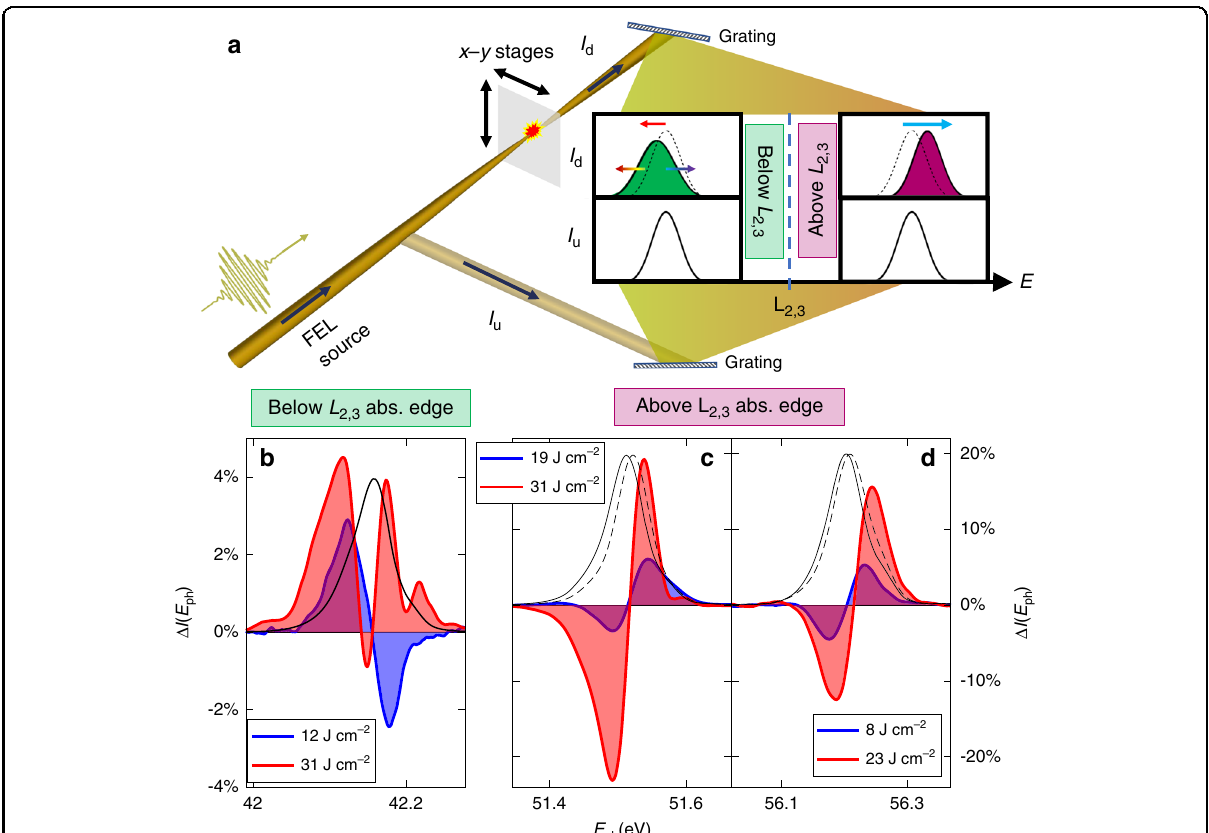
Fig. 1 Experimental results in Mg. a Simpli fi ed sketch of the experimental setup (see Methods section). The single-shot spectra of the pulses are collected with two spectrometers (depicted as a couple of gratings) upstream ( I u ( E ph )) and downstream ( I d ( E ph )) of a Mg sample foil. The NLEs are obtained comparing the two FEL spectra, demonstrating a spectral blue-shift above the L 2,3 absorption edge. On the contrary, spectral red-shift and broadening can be observed below edge. The averages of the differences Δ I = 〈 I d − I u 〉 is reported for a FEL photon energy (~42.1 eV) below the Mg L 2,3 -edge ( b ) and for two photon energies (~51.5 and ~56.2eV) above it ( c , d ). The red and blue curves correspond to Δ I at the highest and lowest fl uence. Averaged FEL spectra 〈 I 〉 , scaled to improve readability, are shown by solid black lines. The blue-shift in c,d can also be appreciated u ( E ph ) comparing 〈 I u ( E ph ) 〉 and 〈 I d ( E ph ) 〉 at the largest fl uence (dashed black